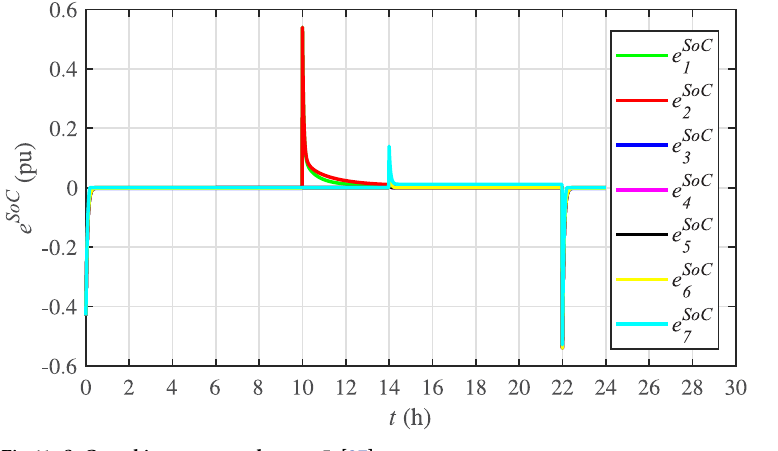
Fig 41. SoC tracking errors under case 5. [27].